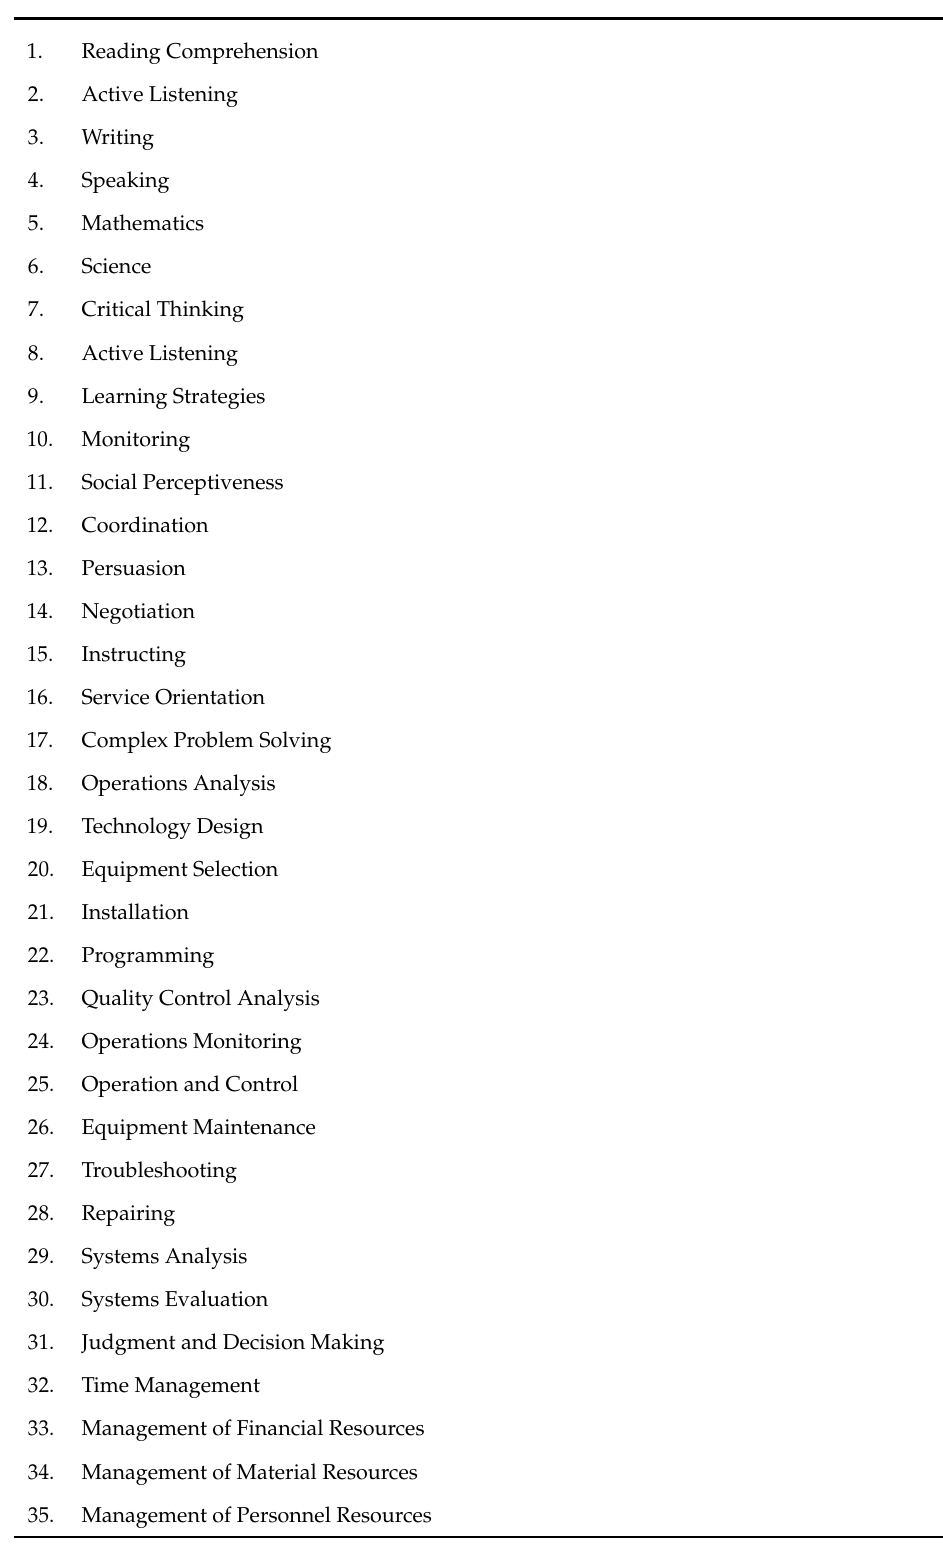
Table A2. O*NET Skills Questionnaire Items (numbered as in the